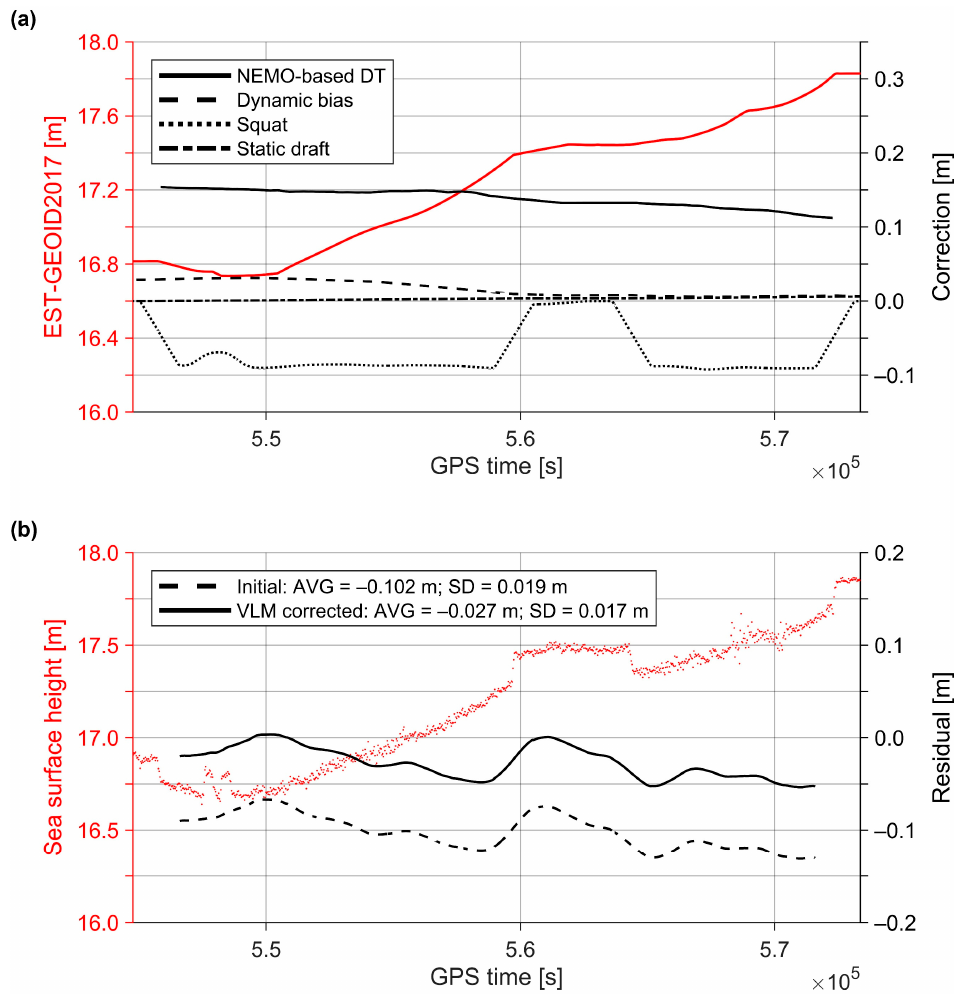
Figure 7. The ( a ) corrections applied to the GNSS profile and ( b ) residuals ( r C ) of the GNSS profile (after removing geoidal heights and DT, as well as applying the vessel-related corrections), where average and standard deviation of residuals are denoted by AVG and SD, respectively. The red dots in ( b ) represent instantaneous ellipsoidal sea surface heights.